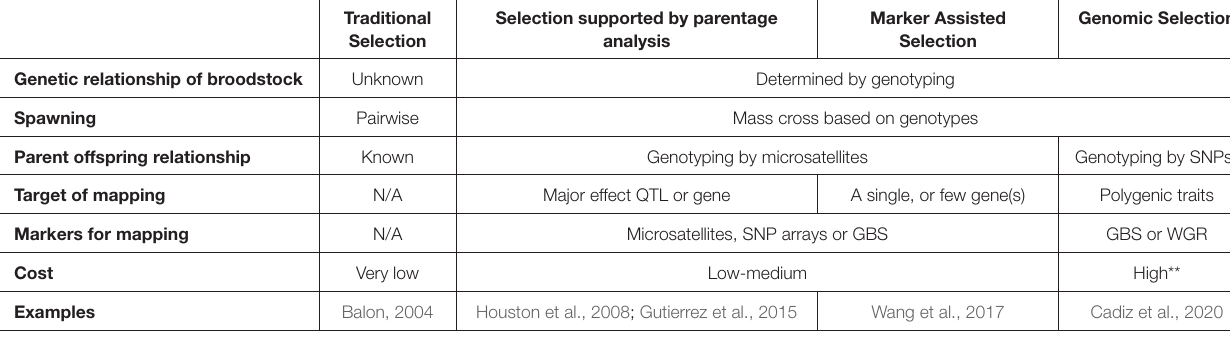
TABLE 2 | Comparison of different selection methods used in